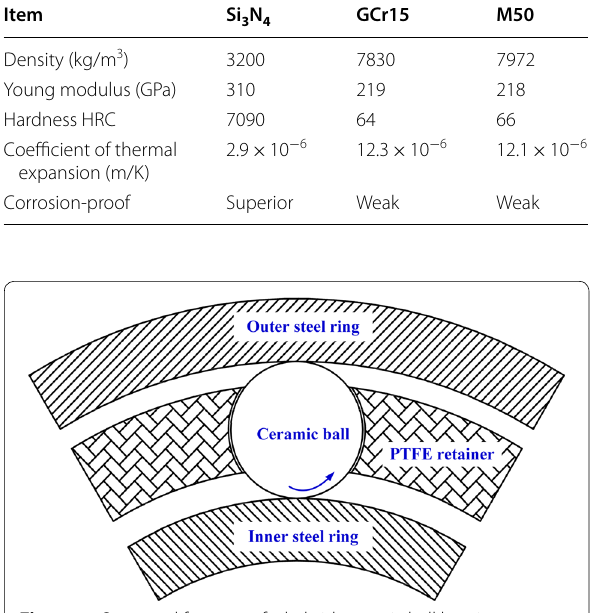
Figure 4 Structural features of a hybrid ceramic ball